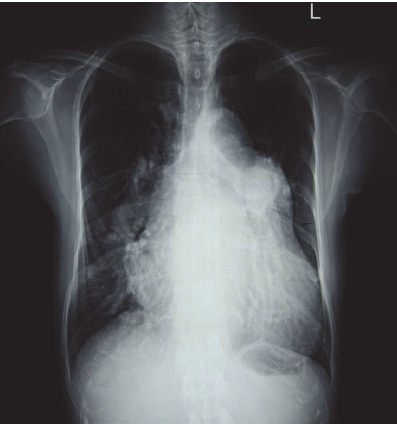
Figure 1: Plain radiographic features of pulmonary artery dissec- tion. Posteroanterior chest radiograph showing cardiac enlargement and pulmonary arterial overcirculation. Pulmonary arterial overcir- culation is indicated by prominent pulmonary arterial segments and greatly dilated hilar vessels.